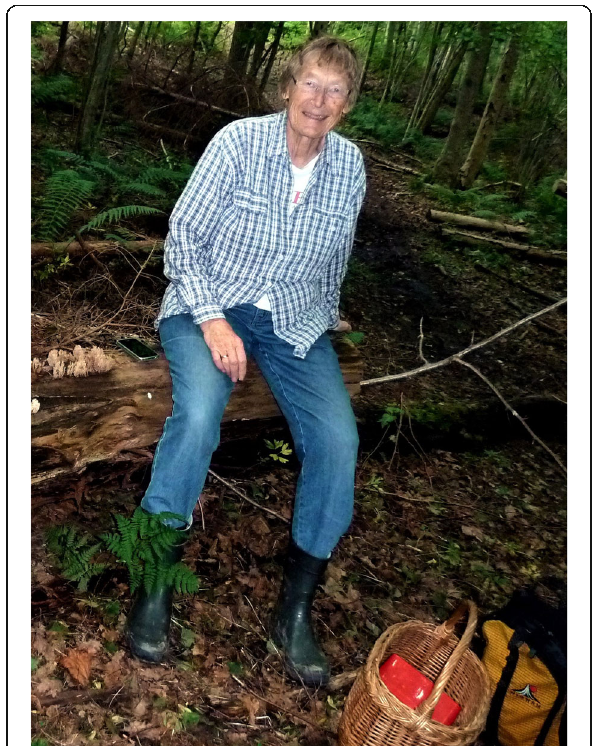
Fig. 11 Gro Gulden. Photo: Inger Kristoffersen